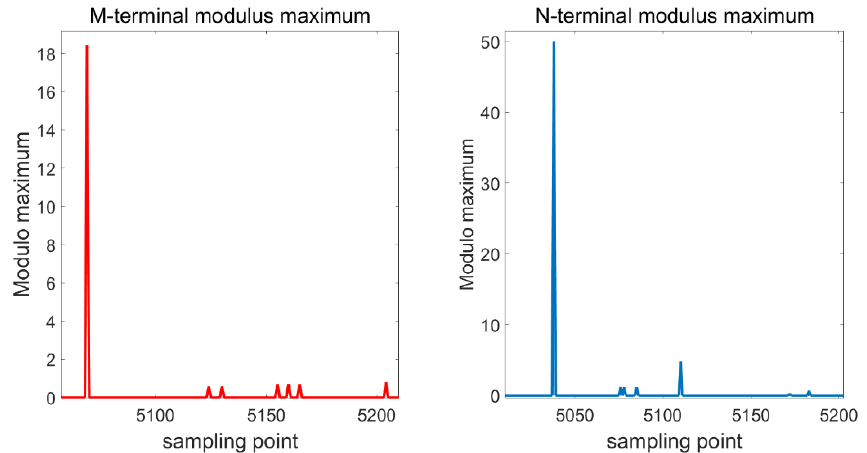
Figure 11. M-terminal and N-terminal voltage modulo maximum values.